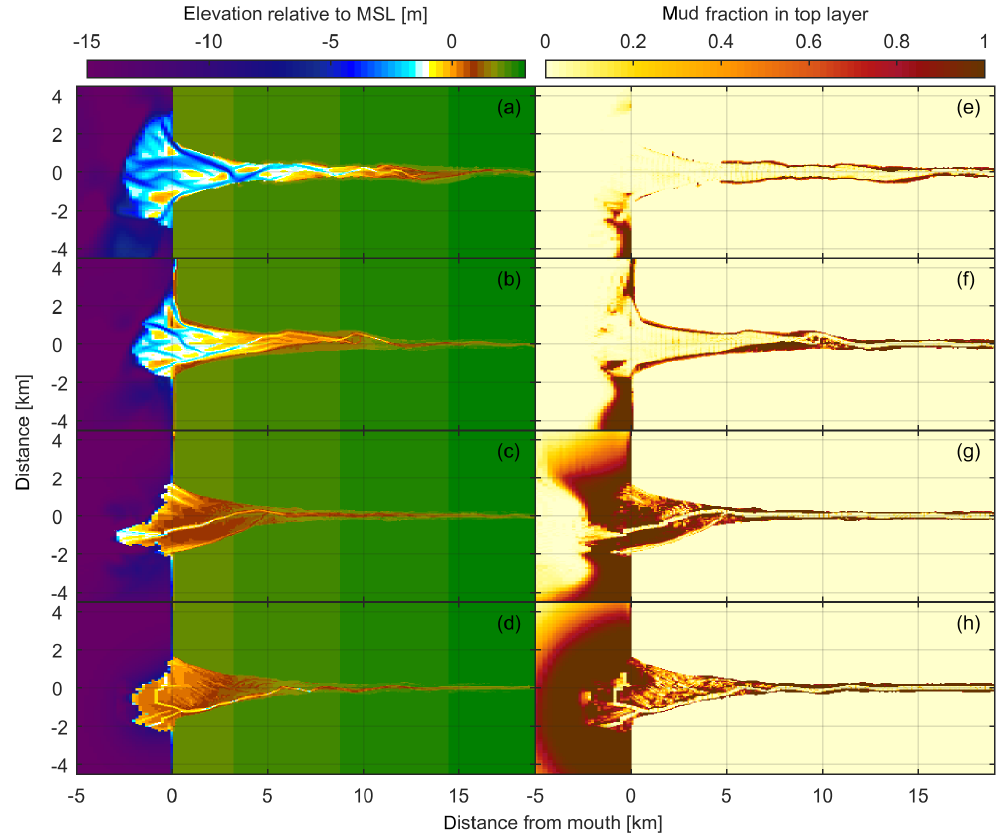
Figure A7. Effects of tidal range (runs 06, 01, 05 and 20). The left column shows the final bathymetry of model runs after 2000 years and the right column shows mud fractions in the top layer of the bed. Run with (a, e) 4m, (b, f) 3m (default), (c, g) 2m and (d, h) 1m tidal